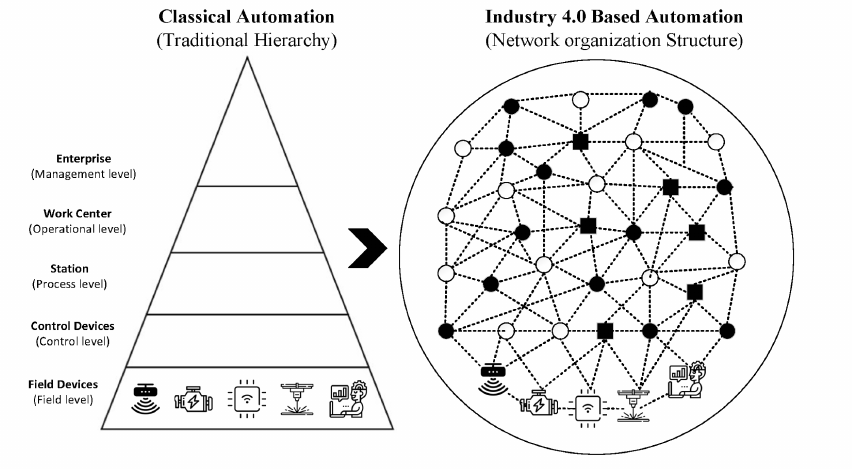
Figure 8. Classical automation pyramid laid side by side with a CPS-based automation model.